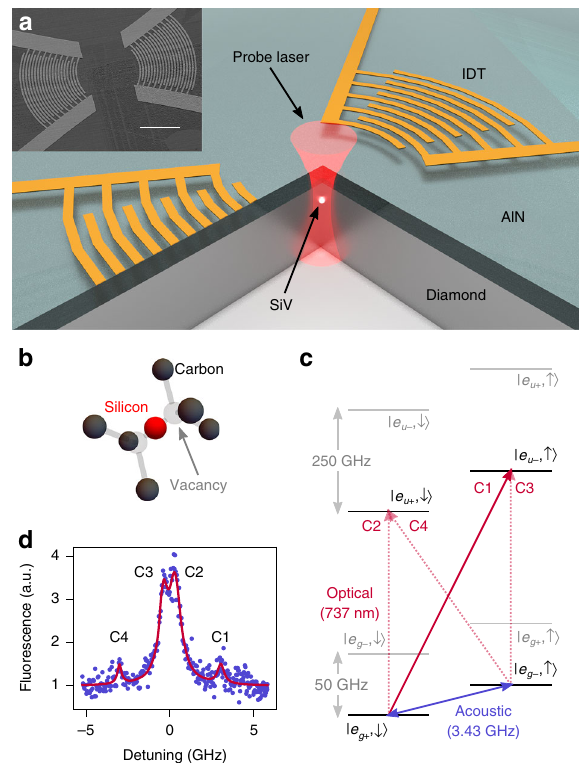
Fig. 1 Layout of surface acoustic wave (SAW) devices, and structure of the silicon vacancy (SiV) center. a Schematic of our diamond SAW device. A microwave signal applied to one of the interdigital transducers (IDTs) generates acoustic waves due to the piezoelectric response of aluminum nitride (AlN). SiVs in the diamond are probed using a focused laser beam. (Inset) A scanning electron microscope (SEM) image of a pair of transducers. The scale bar corresponds to 20 μ m. b Molecular structure of the SiV. c Electronic structure of the SiV under non-zero external magnetic fi eld. The solid red arrow indicates the optical transition used for spin initialization and readout, and the dashed red arrows indicate other optical transitions. The blue arrow indicates the acoustic transition between the two levels of the spin qubit. d Optical fl uorescence spectrum of the C- transition of the SiV under resonant optical excitation, showing fi ne structure. The four peaks correspond to the transitions C1 –